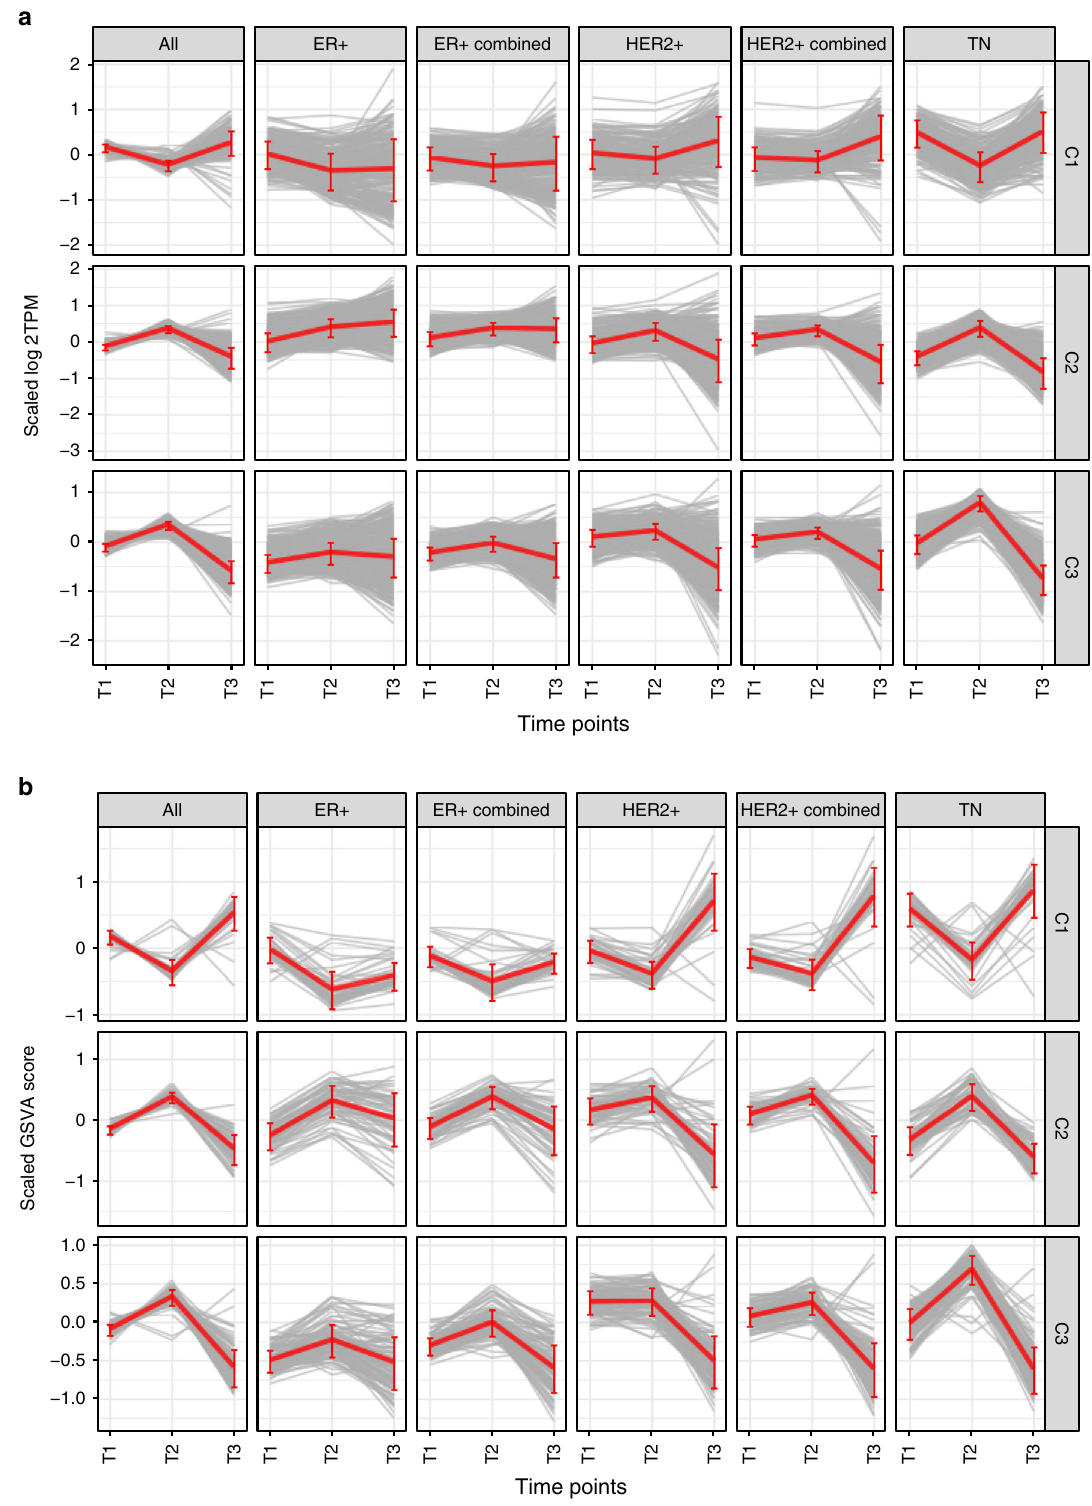
immunity, we quanti fi ed the density of TILs by performing digital image analyses of H&E slides and analyzed changes over time (Fig. 4 and Supplementary Data 4, Supplementary Table 2). The majority of tumors exhibited an increase in TIL density at three weeks after the fi rst cycle of NAC followed by a drop to below baseline levels at surgery, with the pattern of change varying across subtypes and pCR status (Fig. 4a). TIL density increases